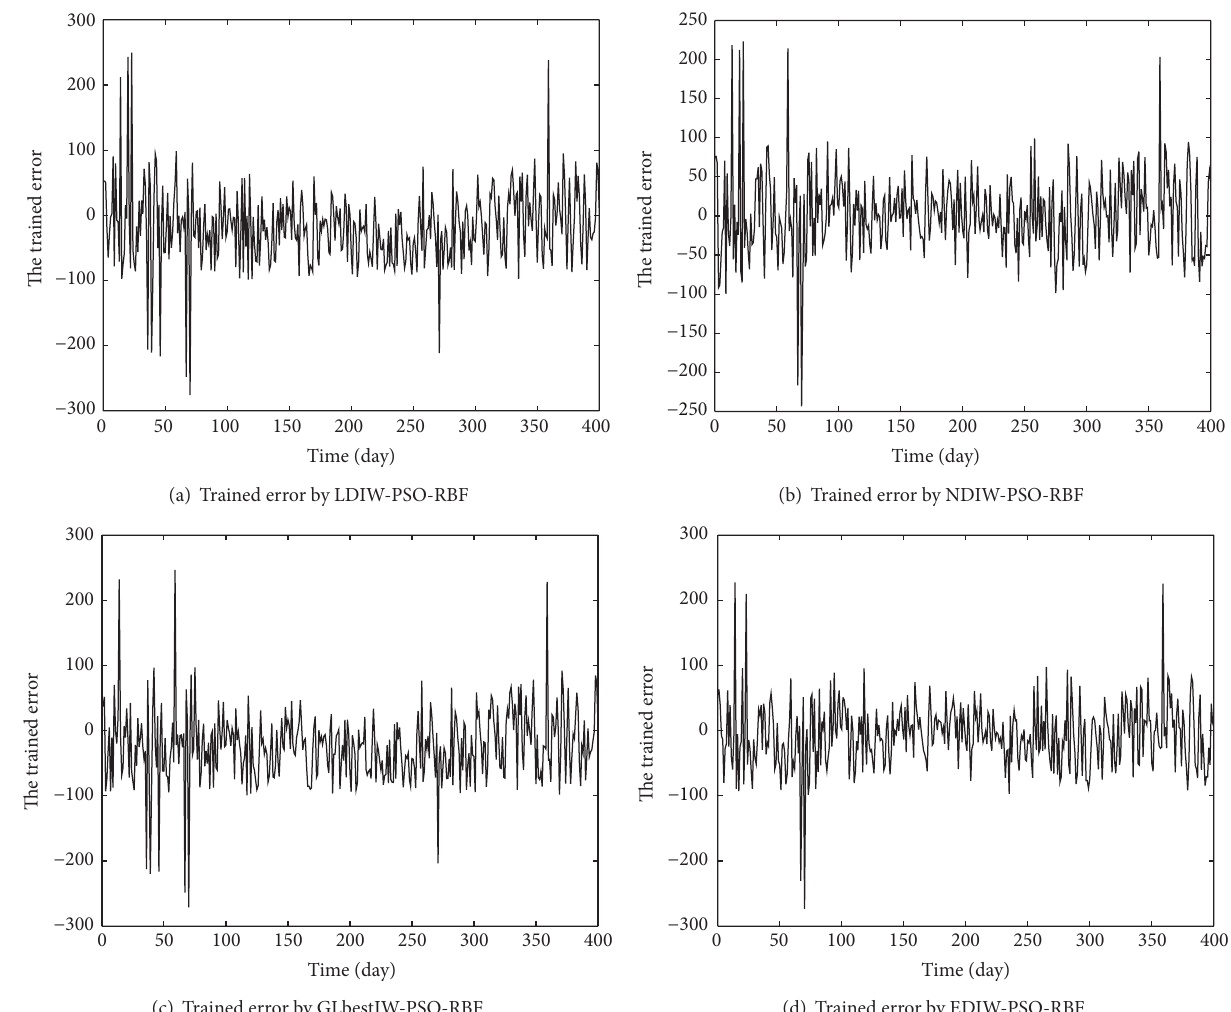
Figure 6: Plots of trained absolute errors between the trained outputs and the actual values by four models for the daily air quality index (AQI) of Xi’an.